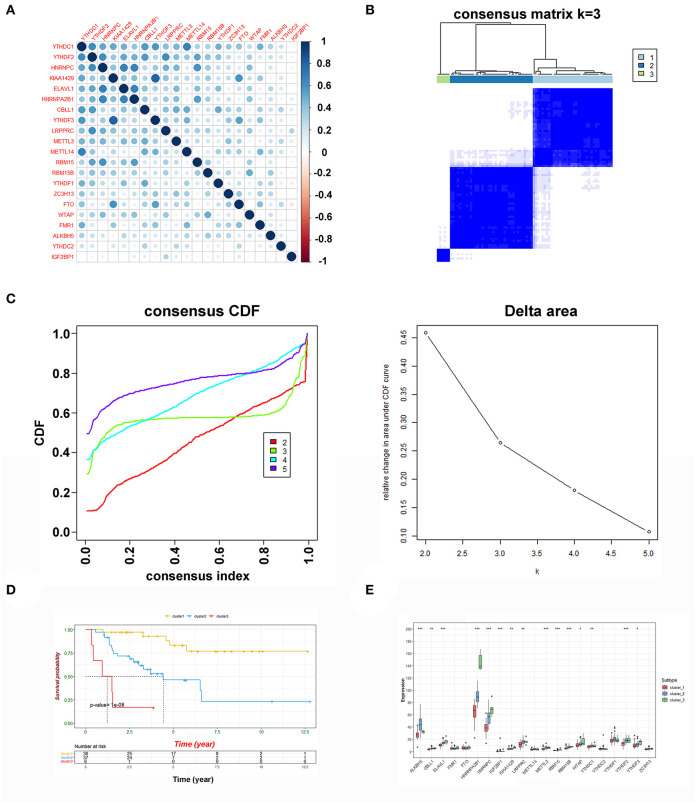
Consensus clustering of m6A genes. (A) The Pearson correlation analysis was used to search the relationship among m6A regulators. (B) Consensus clustering matrix for k = 3. (C) Consensus clustering cumulative distribution function (CDF) and relative change in area under CDF curve for k = 2 to 5. (D) Kaplan-Meier curves of OS for three clusters in ACC. (E) The expression of the 21 m6A regulatory factors in clusters (***P < 0.001; **P < 0.01; *P < 0.05).